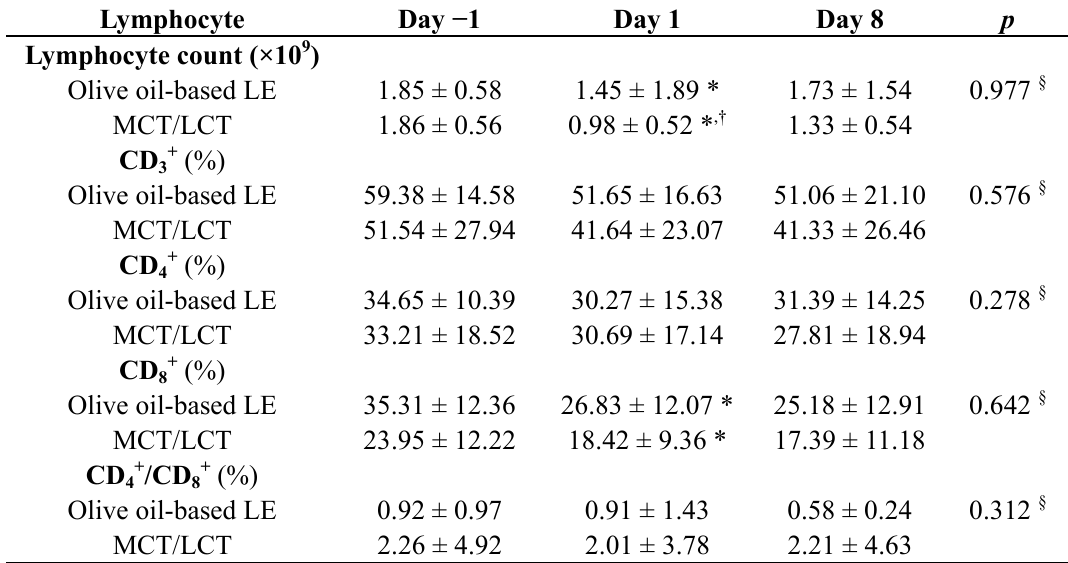
Table 5. Comparison of lymphocyte count and subpopulations between the two groups.